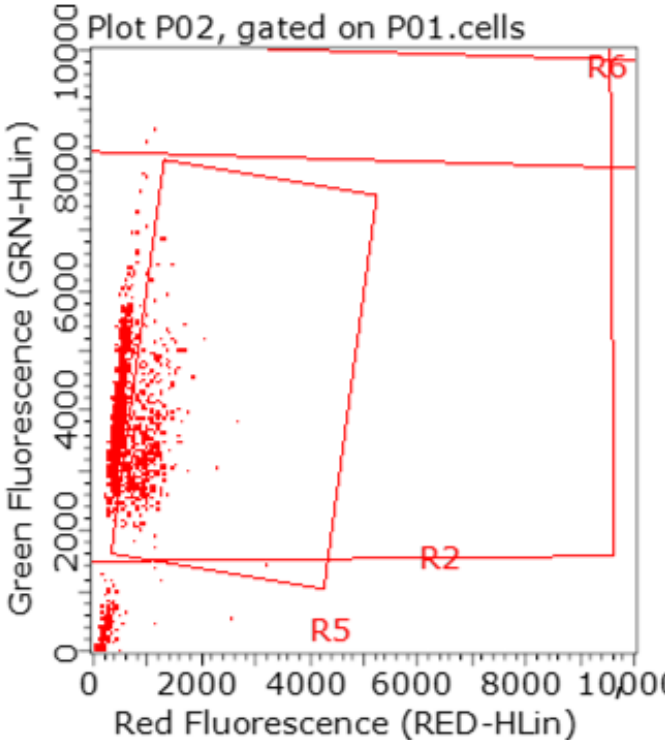
Figure 11. An example of a dot plot with 29.85 percent of spermatozoa with DNA fragmentation in the red rectangle in the Control group, determined according to the DNA fragmentation index (% DFI).